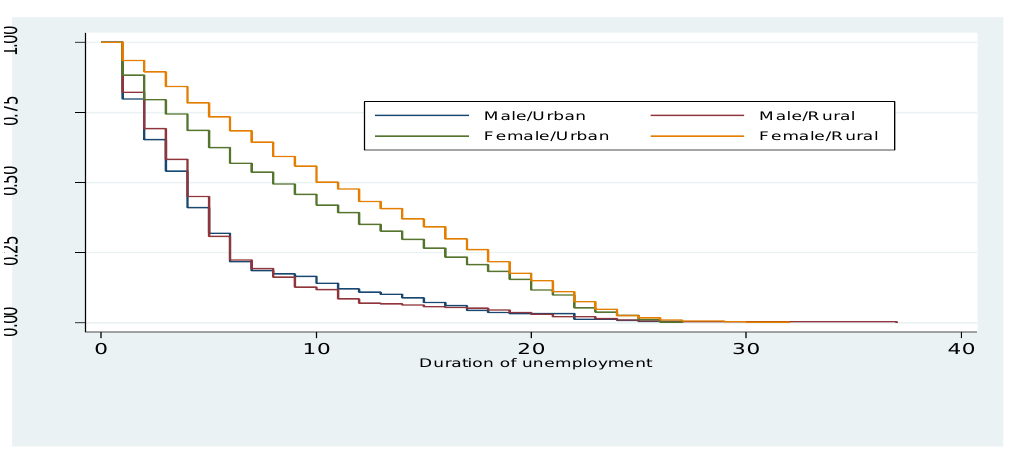
Figure 17: Survival function by gender and area of residence